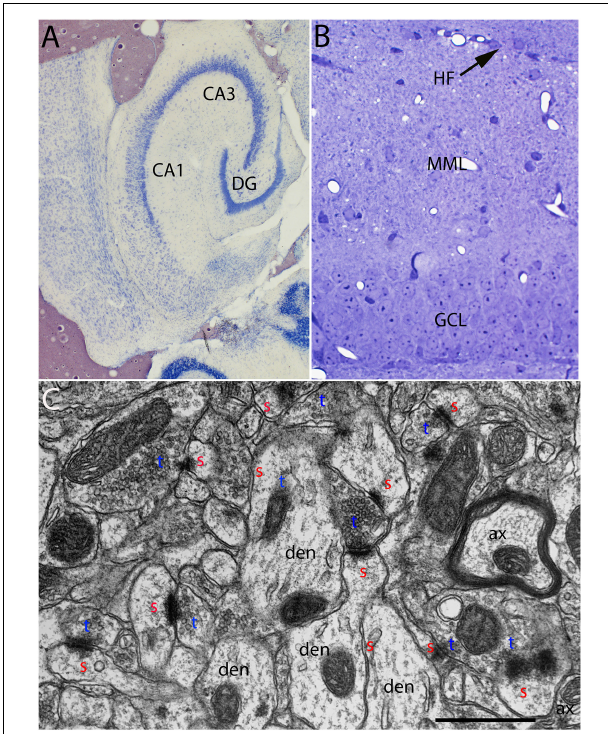
FIGURE 1 | (A) Cresyl violet stained horizontal section illustrating an example of the entorhinal cortex lesions. (B) Toluidine blue-stained section illustrating the dorsal blade of the dentate gyrus and the area containing degenerating synapses in the outer molecular layer. (C) Normal ultrastructure of synapses in the middle molecular layer of the dentate gyrus. CA1–CA3, subdivisions of the hippocampus; DG, dentate gyrus; HF, hippocampal fissure, the boundary between the distal dendrites of granule cells and distal dendrites of hippocampal neurons in CA1; MML, middle molecular layer; GCL, granule cell layer; red s, spine head; blue t, synaptic terminal; den, dendrite; ax, myelinated axon.